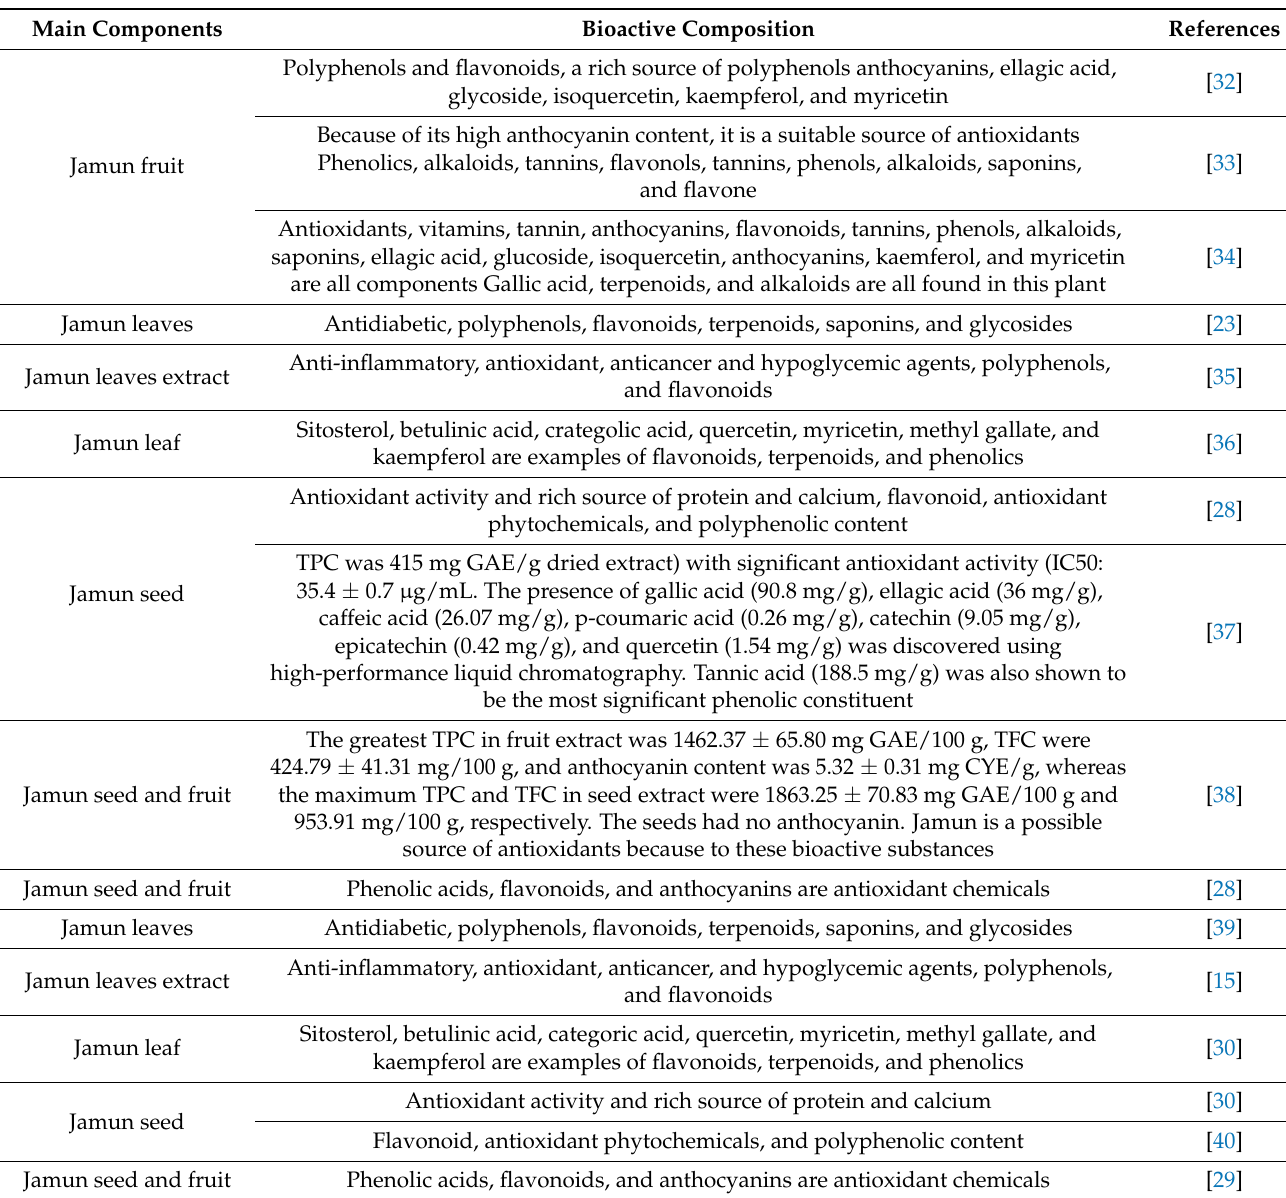
Table 2. Main components and the bioactive composition of